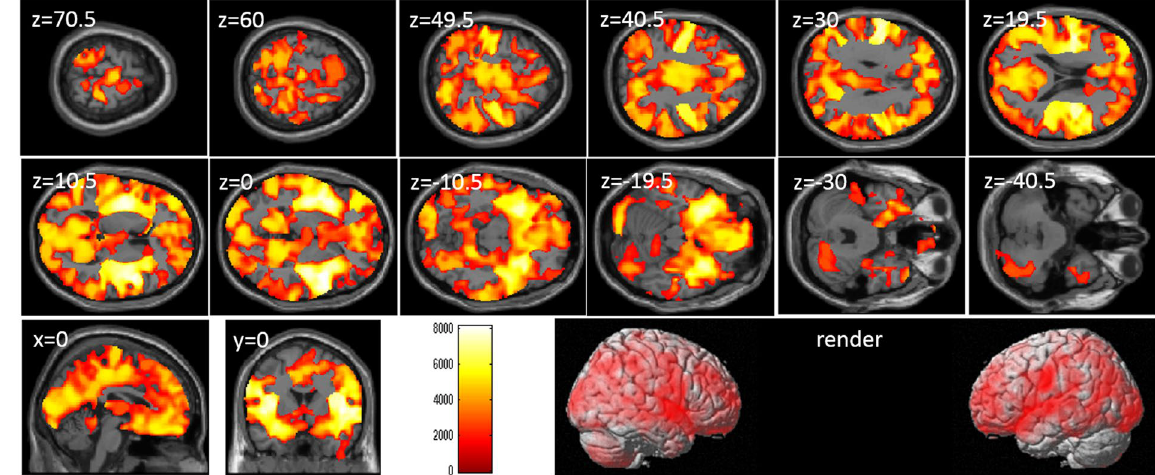
Figure 1. Relationships between verbal working memory (WM) and regional gray matter volume (rGMV). Individual panels represent areas of significant positive correlation between the digit span score and rGMV by multiple regression analysis corrected for effects of age and sex. The results shown were obtained using a threshold of TFCE, P < 0.05 corrected (FWE) based on 5000 permutations. The color bar represents the threshold-free cluster enhancement (TFCE) values. Significant positive correlations were found across the whole brain.